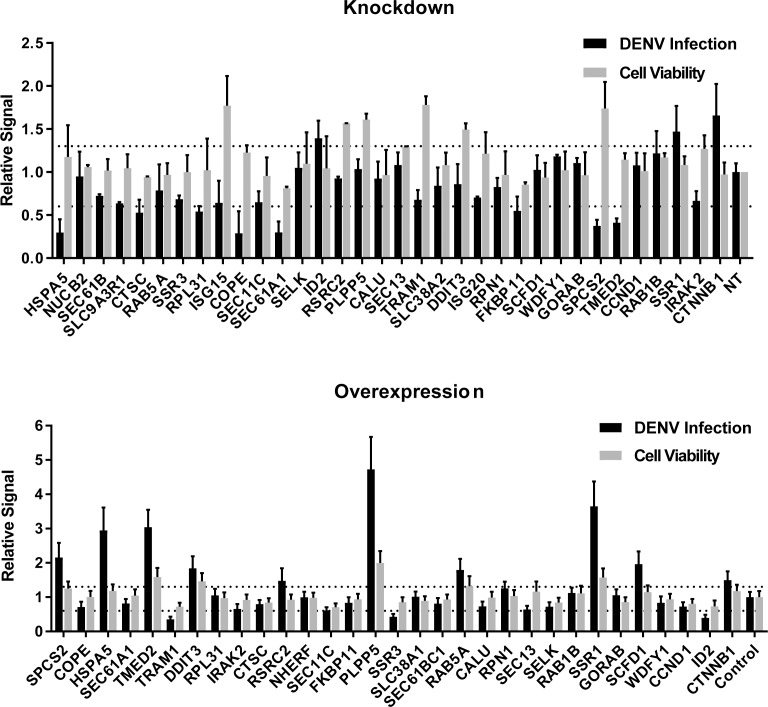
siRNA (A) and ectopic expression (B) screens testing the involvement of the indicated host factors in DENV infection.Overall DENV infection (black) measured by luciferase assays and relative cell viability (grey) measured by alamarBlue assays at 48 hr post-infection of siRNA-transfected or ectopically expressing Huh7 cells. Data are expressed relative to NT siRNA (A) or empty plasmid control (B). Data are an average of two independent screens with three replicates each. The dotted lines represent the cutoffs for positivity.